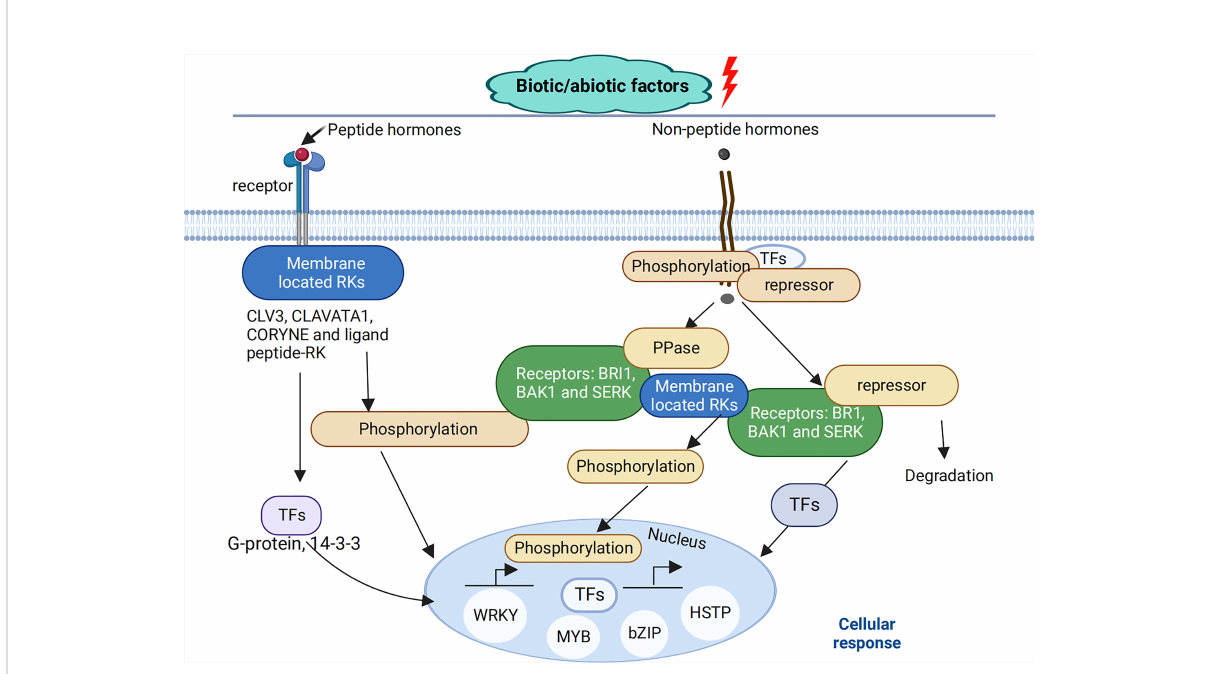
FIGURE 1 Plant cellular signaling cascades. Throughout their developmental period, plants are attacked by different biotic and abiotic stresses. These stress signals are recognized by membrane-located RKs, which play an important role in plant signaling pathways either through peptide hormones such as CLAVATA3, CLAVATA1, CORYNE and other ligand peptides – RK interactions or non-peptide hormones, such as a membrane-bound receptor named brassinosteroid-insensitive 1 (BRI1), which interacts with BCL2 antagonist/killer1 (BAK1), and somatic embryogenesis receptor-like kinase (SERK) shown to be involved in different signaling pathways under stress conditions. These transmembrane receptor-like kinases transmit signals through the plasma membrane, which activates a signaling cascade related to post-translational modi fi cations of proteins, with signals activating the expression of transcription factors (TFs), such as myb-related protein (MYP), basic leucine zipper (bZIP), heat stress transcription factor (HSTP), WRKY, etc., as a form of response to these